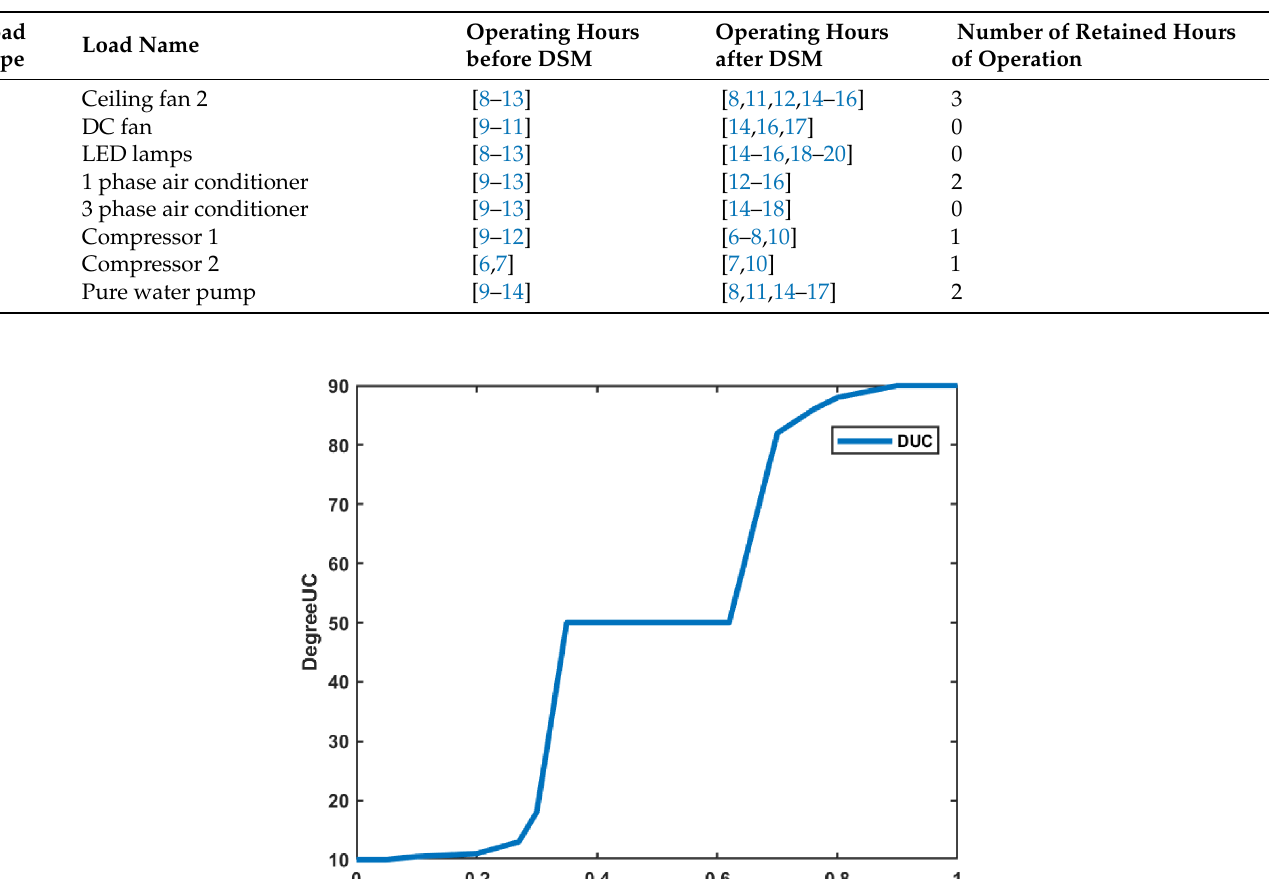
Table 6. Operating hours of loads before and after DSM.